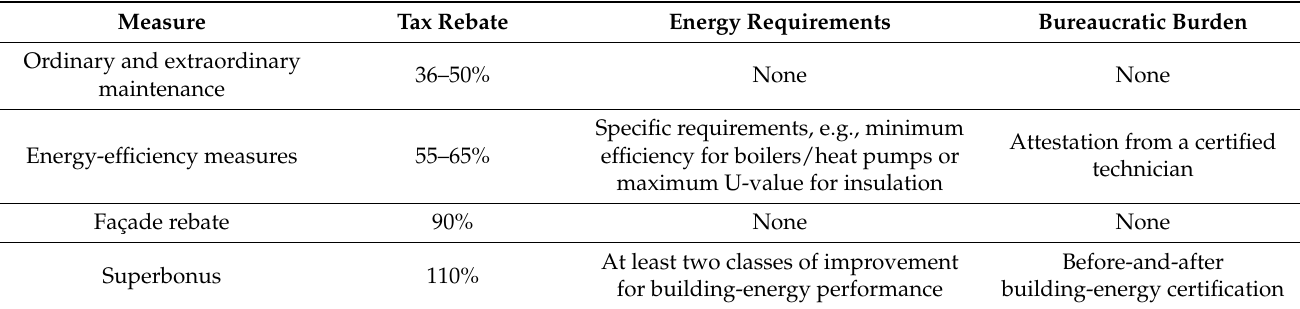
Table 10. The existing framework of incentive measures for the building sector in